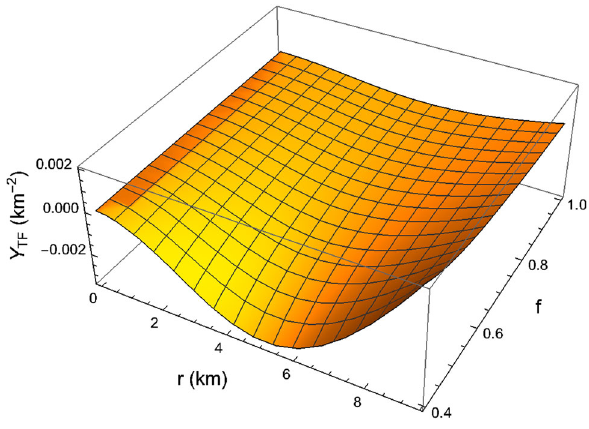
Fig. 4 Complexity factor progression for K = −